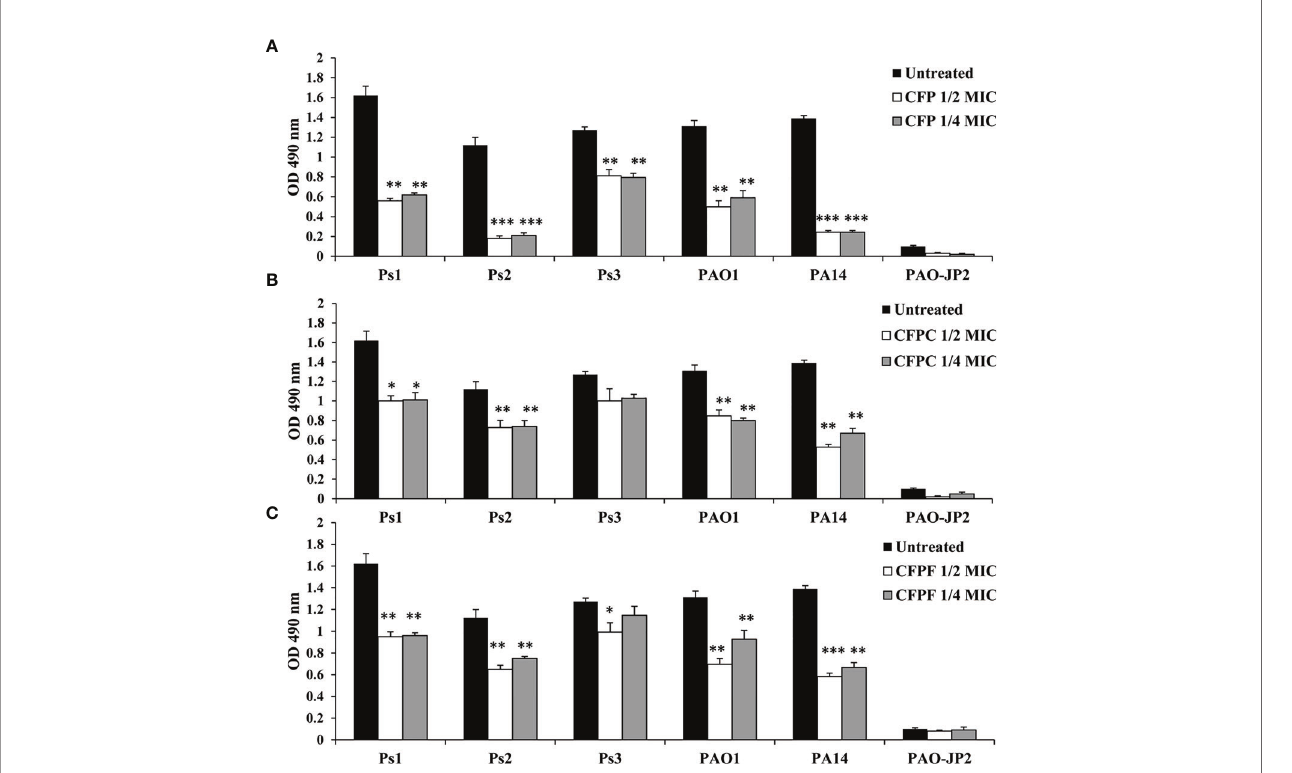
FIGURE 4 | Bio fi lm formation; Effect of sub-MICs; 1/4 and 1/2 of Cefoperazone (CFP) (A) , Cefoperazone-Cobalt complex (CFPC) (B) and Cefoperazone-Iron complex (CFPF) (C) on bio fi lm formation in P. aeruginosa strains, Ps1, Ps2, Ps3, PAO1, PA14 and PAO-JP2 (negative control) compared to the untreated cultures.